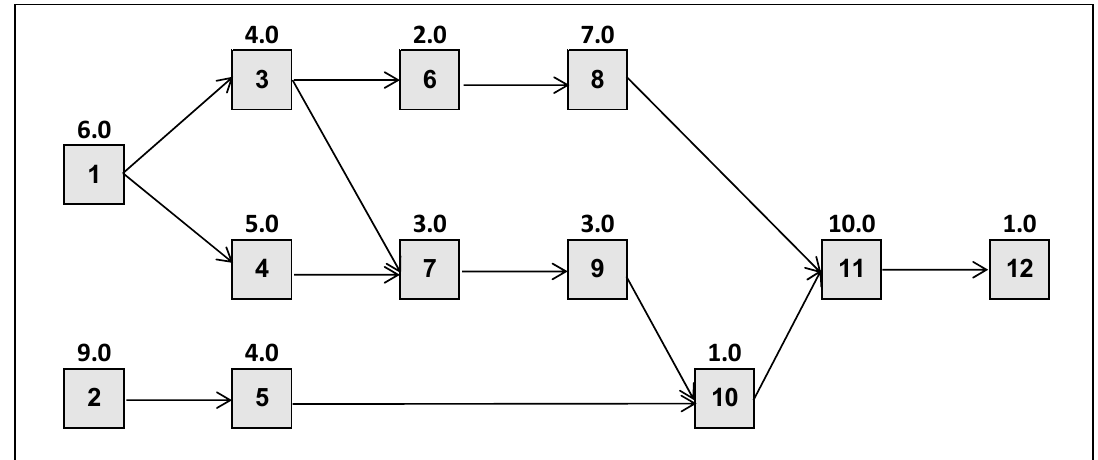
Figure 1. Precedence relationships between tasks for “combined” model Omega. Values above the squares are task times (in seconds).